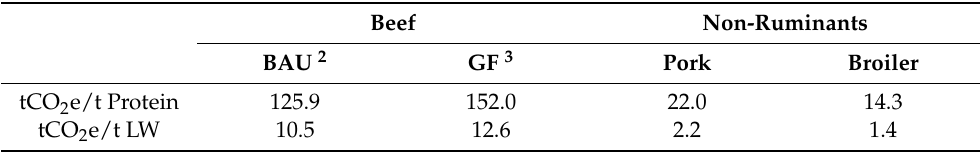
Table 2. GHG emission intensities based on protein and LW 1